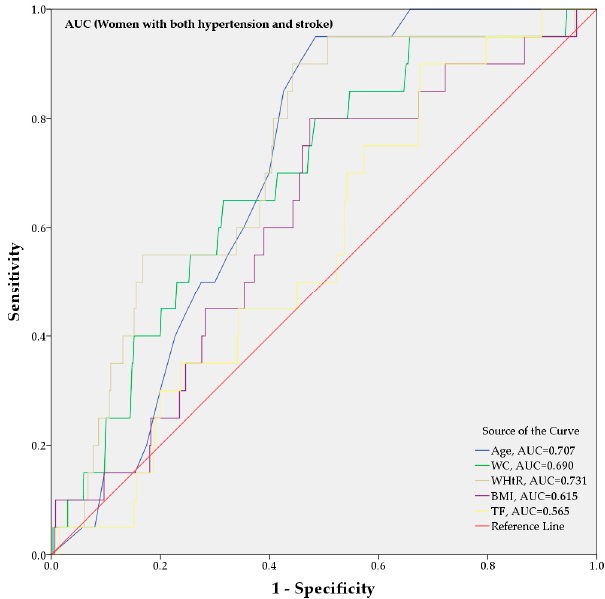
Figure 6. AUC analysis of both hypertension and stroke based on anthropometrics and body composition in women.